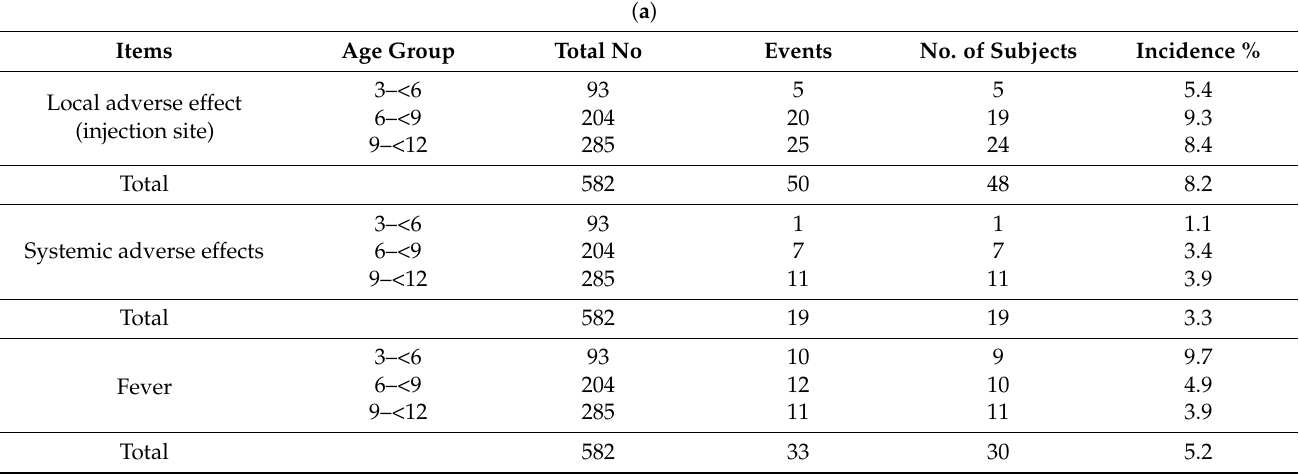
Table A1. ( a ) Incidence of adverse events after the first dose of vaccination. ( b ) Incidence of adverse events after the second dose of